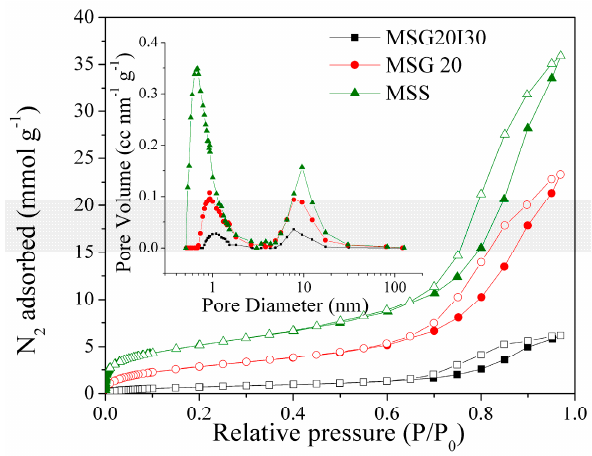
Figure 4. N 2 adsorption/desorption isotherms and pore size distributions (PSD’s) at − 196 °C, open symbols belong to desorption step.